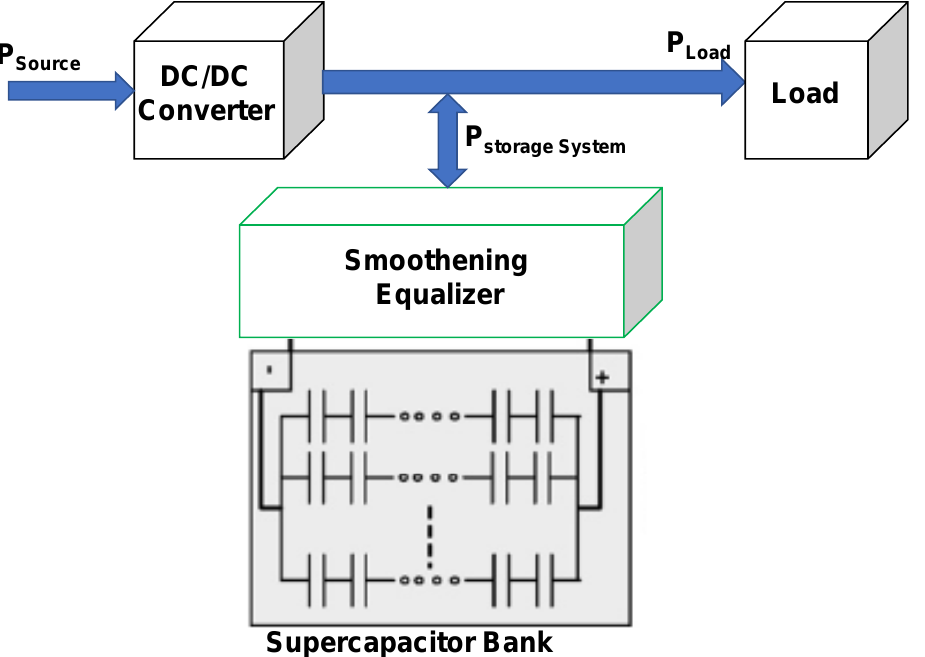
Figure 7. The structure of an SC-based energy storage device.